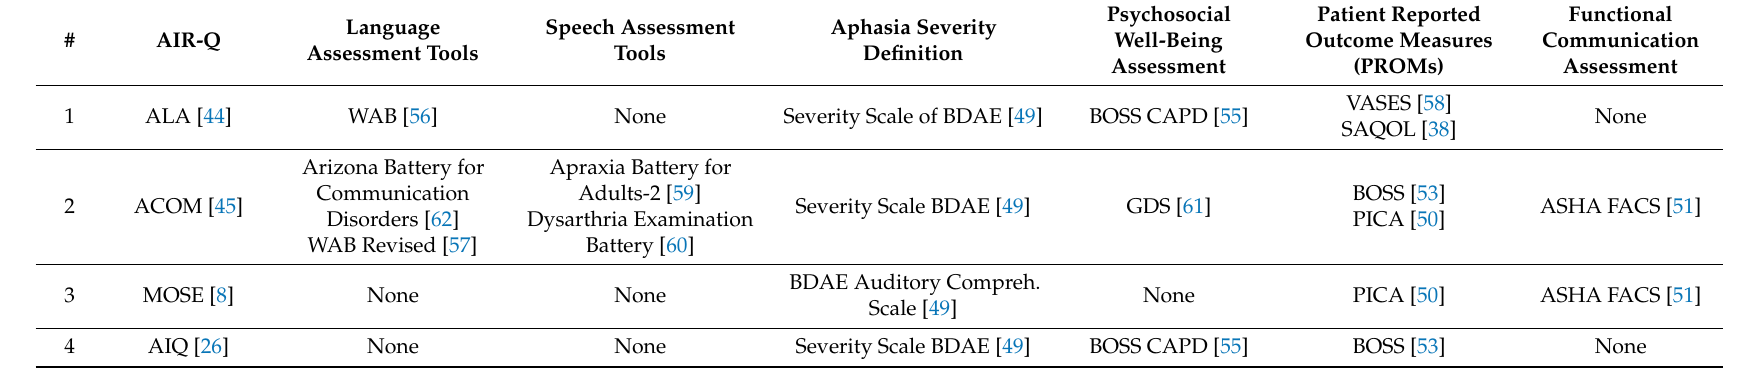
Table 3. Assessment tools used in the four Aphasia Impact Related studies selected in the